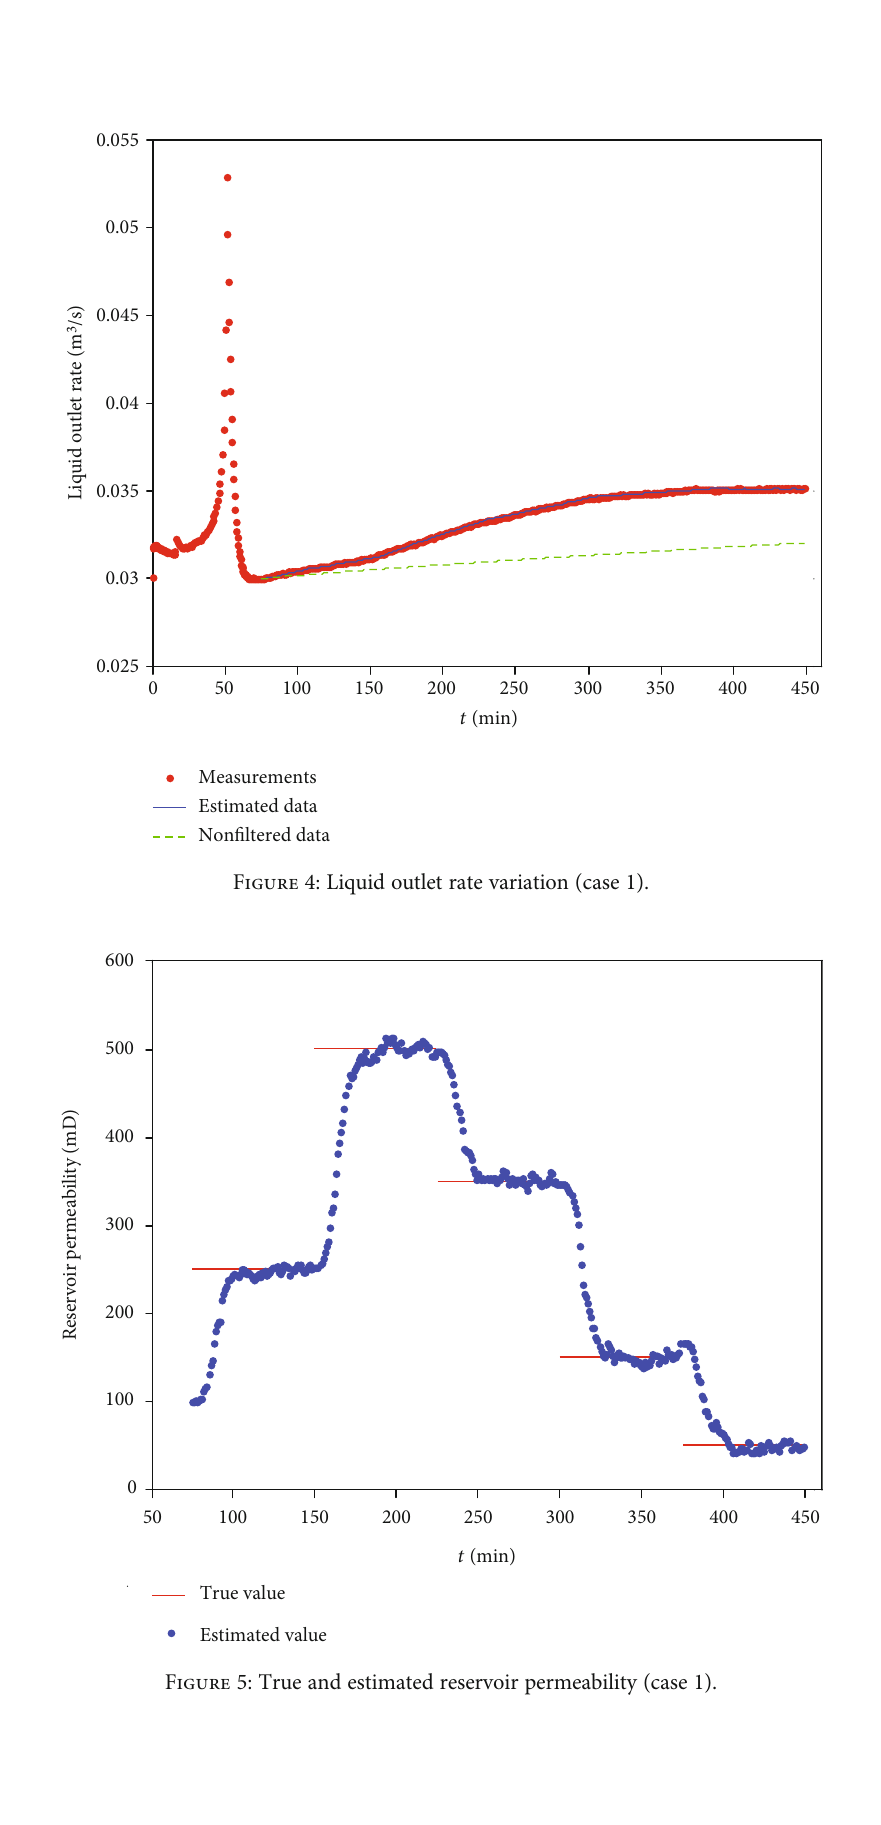
Figure 5: True and estimated reservoir permeability (case